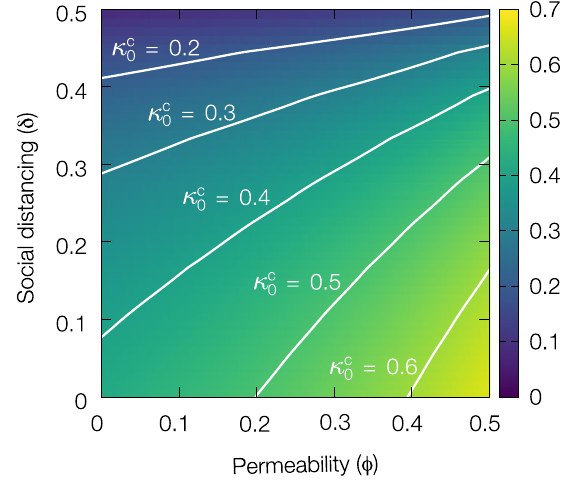
FIG. 6. Relationship between critical confinement, permeabil- ity, and social distance. Critical confinement κ c 0 computed from Eq. (51) needed to ensure that the system reaches the bending regime, i.e., R ¼ 1 , as a function of the household permeability ϕ and the social distance δ